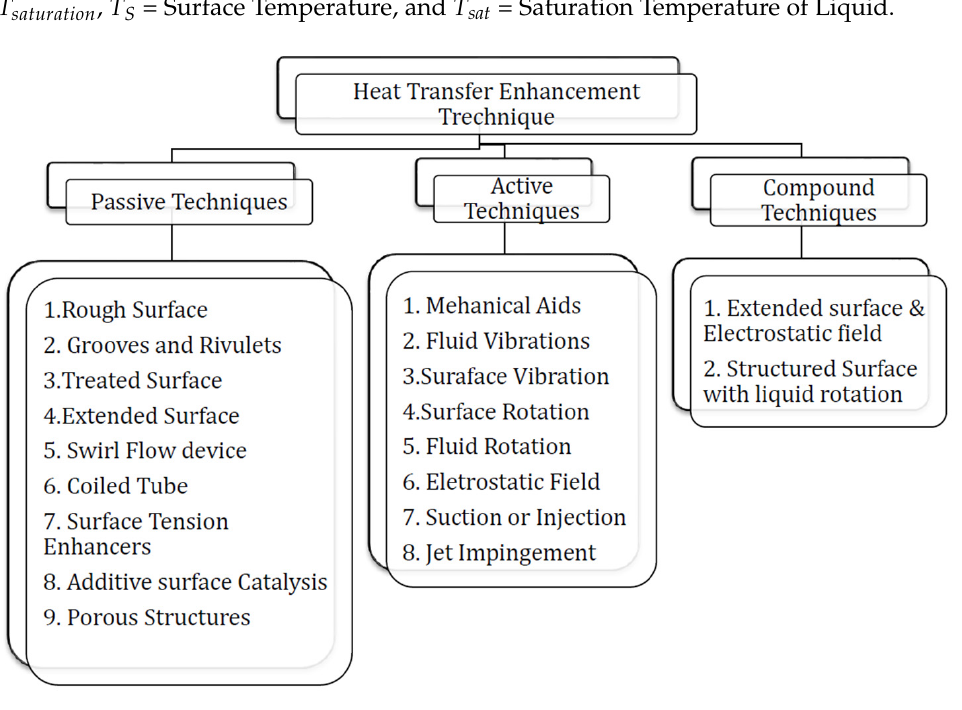
Figure 1. Heat transfer enhancement techniques.